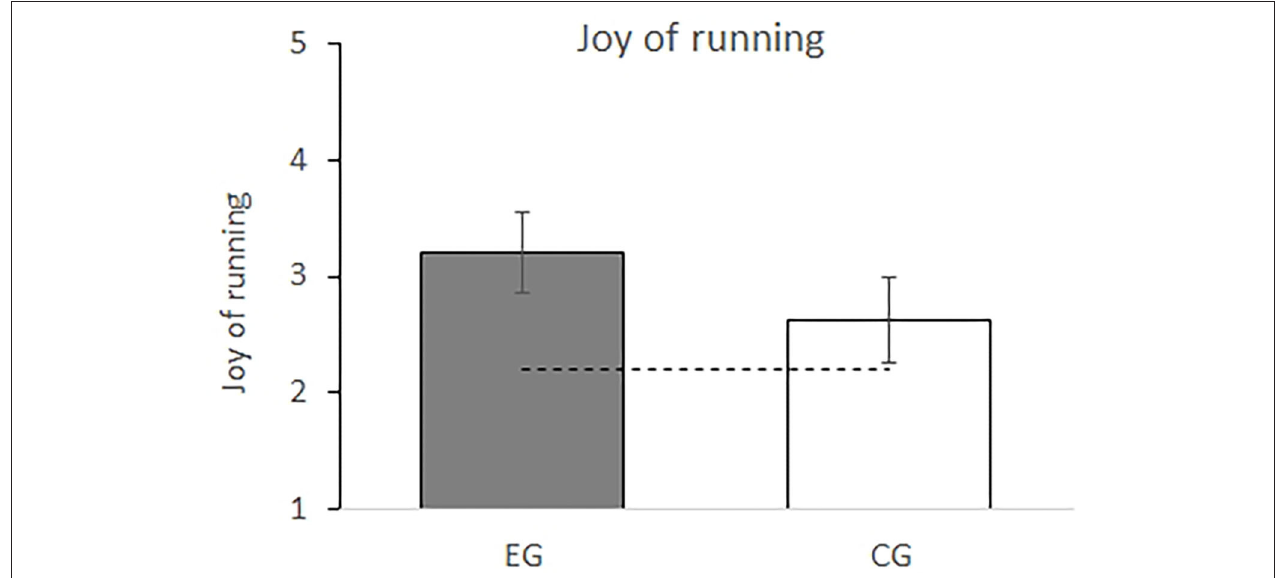
FIGURE 4 | Self-report of how much students enjoyed the 30min run in the experimental (EG, gray bar) and control groups (CG, white bar) with higher scores indicating greater enjoyment. Error bars indicate 95% CI. The dashed line indicates the average of participants’ anticipation to run before any running took place ( M =